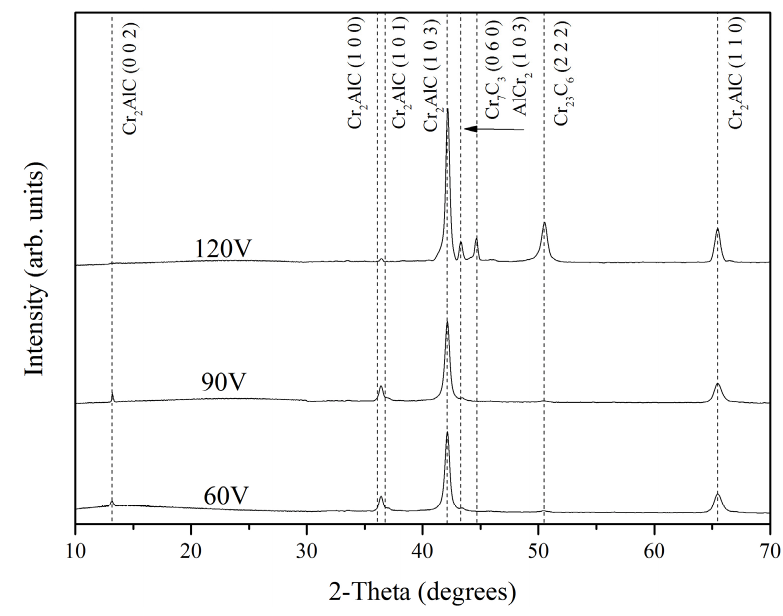
Figure 2. X-ray diffraction (XRD) patterns of the deposited Cr-Al-C coatings.